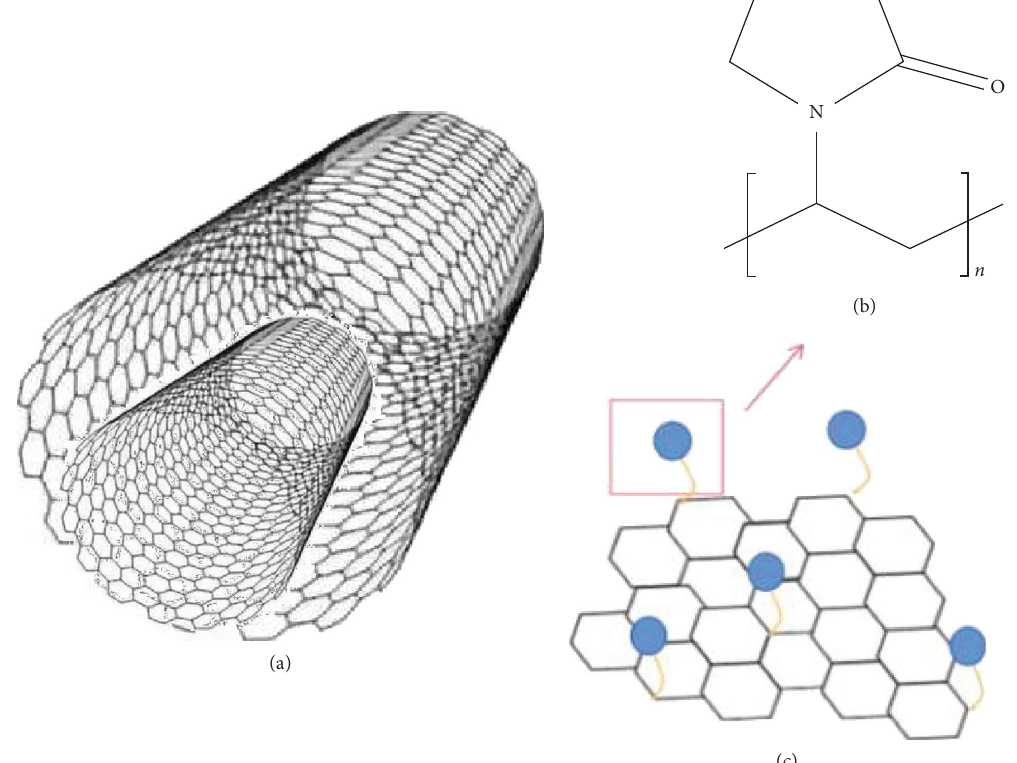
Figure 1: (a) Structure of MWCNT, (b) PVP molecular formula, and (c) a schematic of chemical grafting reaction between PVP and